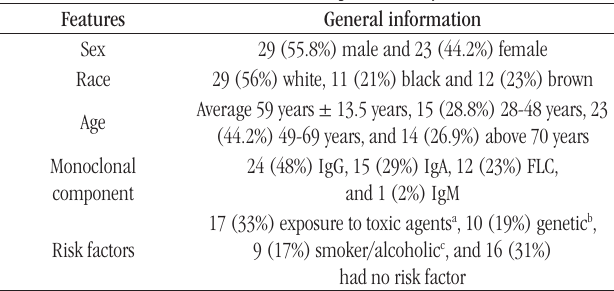
taBLE 1 − Features and general information about 52 patients with MM evaluated in the present study Features General